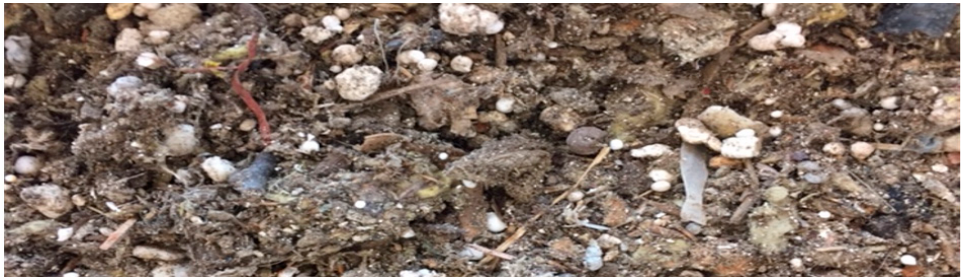
Figure 4. Screen reject from mixed CDW.